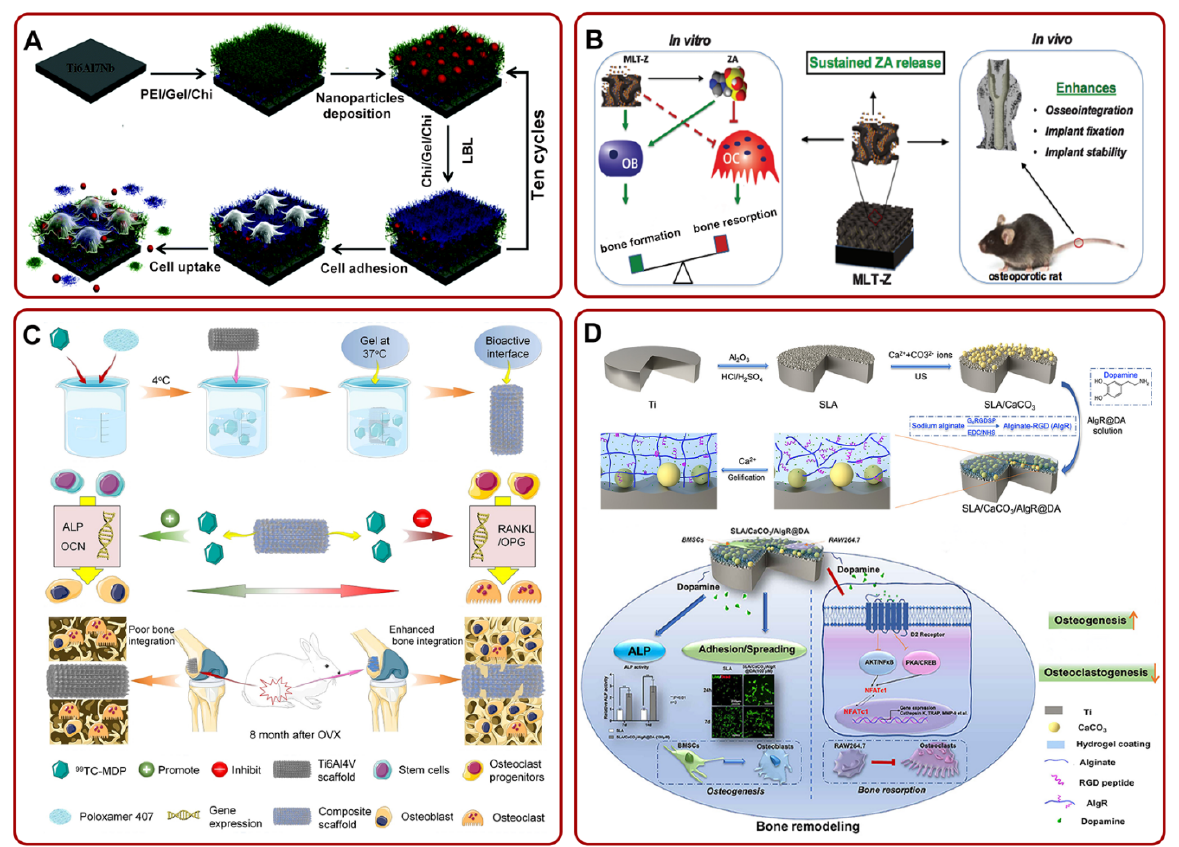
Figure 3. ( A ) The fabrication of Ti6Al7Nb/LBL/NP for suppressing the growth of osteoclasts and promoting local osseointegration. Adapted with permission from Ref. [120]. Copyright 2016, Royal society of chemistry; ( B ) MLT-Z coating could continue to release ZA. The release of ZA could promote bone formation and inhibit bone resorption in vitro, but also enhance osseointegration in vivo. Adapted with permission from Ref. [125]. Copyright 2018, American scientific publishers; ( C ) schematic illustration of the fabrication process of TH/PTI coating. The composite coating could enhance bone–implant integration by facilitating osteogenic differentiation and mitigating the proliferation of osteoclasts. Adapted with permission from Ref. [128]. Copyright 2021, Elsevier; ( D ) the preparation process diagram of SLA/CaCO 3 /AIgR@DA and its potential mechanism of en- hancing osteogenesis and anti-bone resorption. Adapted with permission from Ref. [49]. Copyright